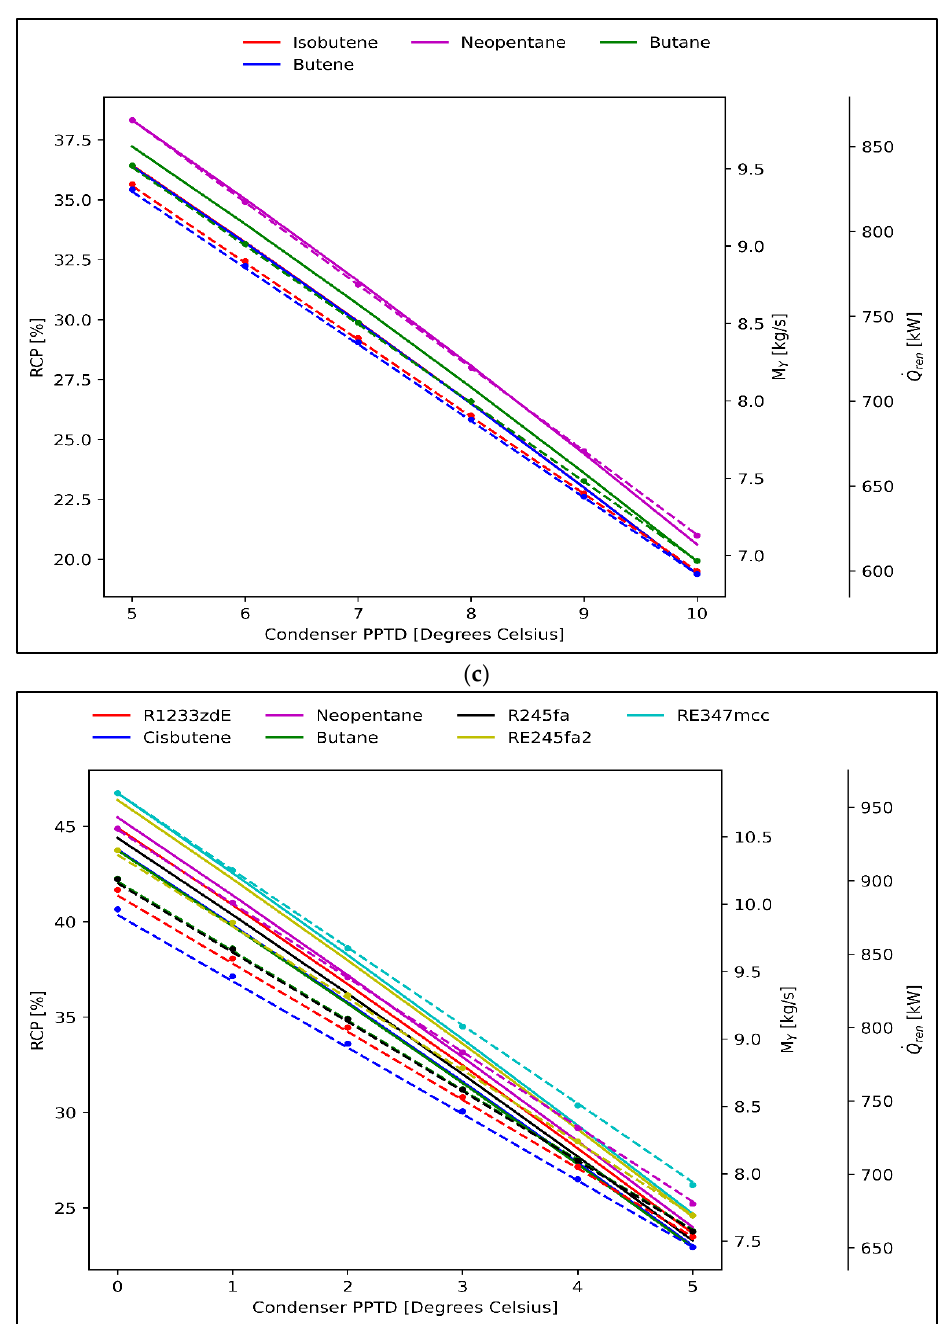
Figure 10. ORC condenser pinch point temperature difference vs. reduction in power consumption and renewable energy input: (a) 90 °C; (b) at 100 °C; (c) at 110 °C; and (d) at 120 °C. Solid Lines: RCP , Dots: 𝑄̇ 𝑟𝑒𝑛 , Dashed Lines: M Y .